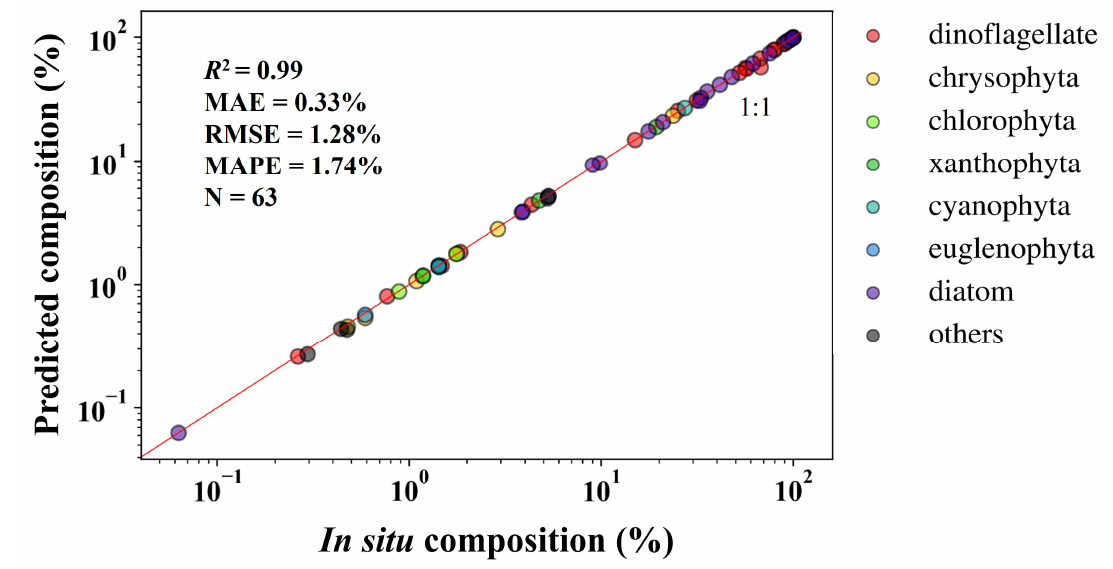
Figure 11. In situ versus NNC TL -predicted compositions (%) of the seven communities in the validation dataset (Section